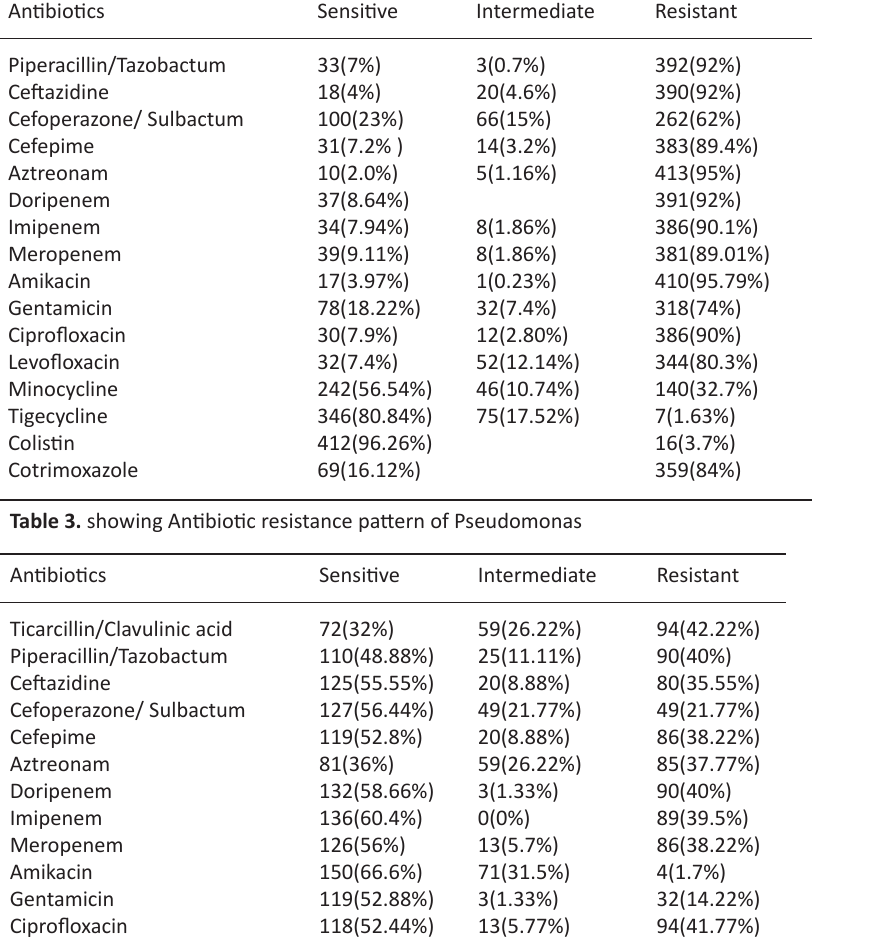
Table 2. Antibiotic Resistance pattern of Acinetobacter Antibiotics Sensitive Intermediate Resistant